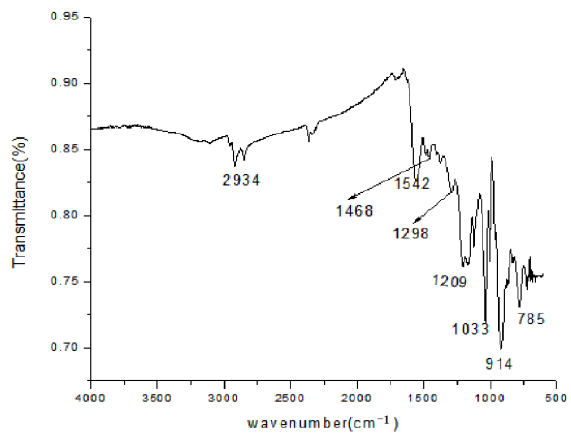
Figure 1. FTIR spectrum of PPy.